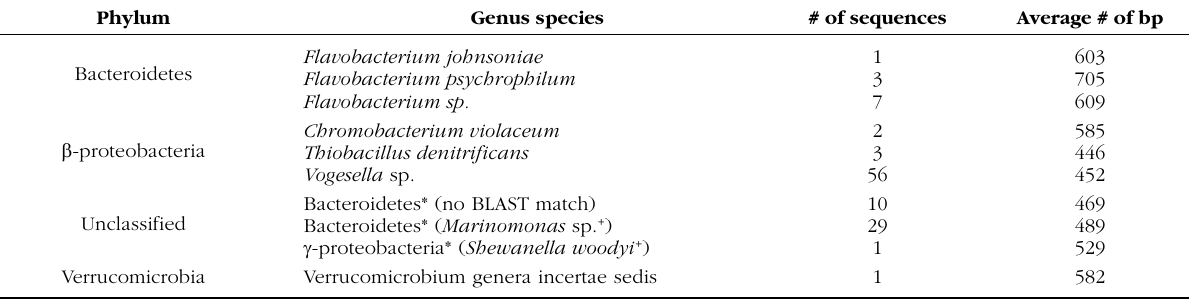
Table i. – The sequence alignment of 113 screened clones from channel catfish and freshwater drum leech homogenate samples. Sequences were classified using the Ribosomal Database Project ii (RDP) and the Basic local alignment Search Tool (BlaST) of the NcBi. The average sequence length (reported as number of base pairs) is also presented for each taxonomic